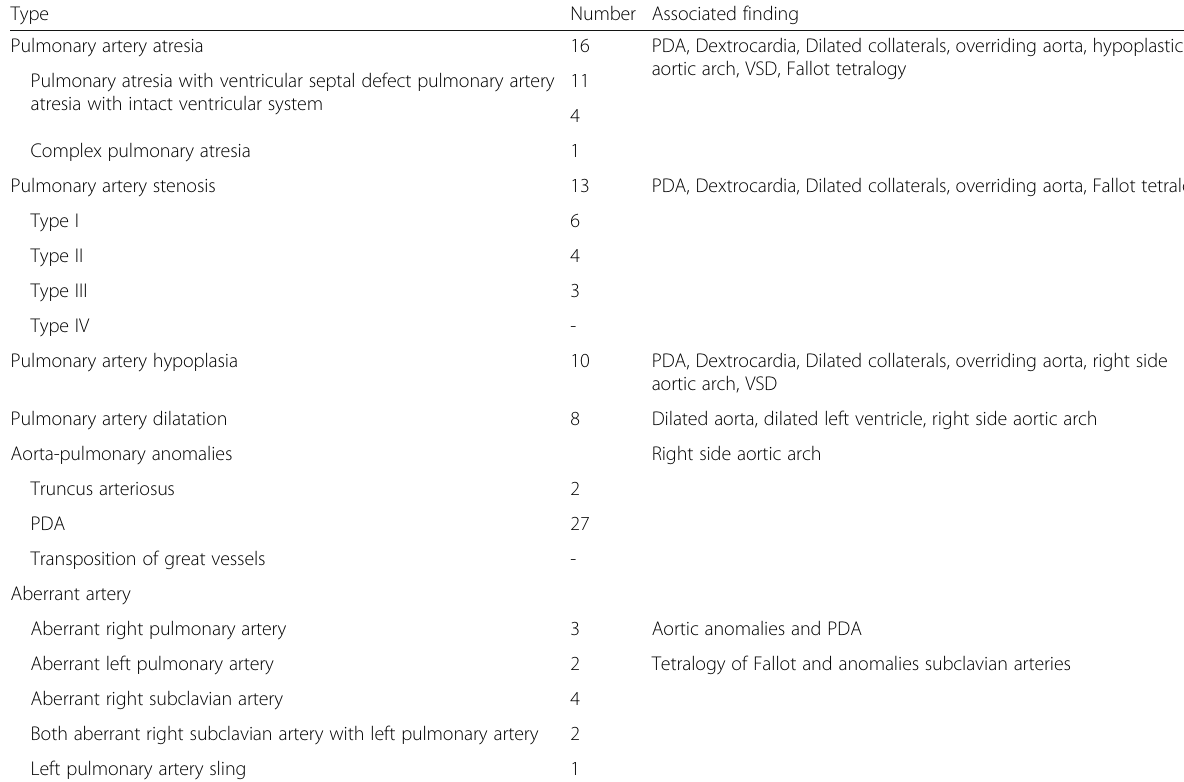
Table 1 Associated finding with the pulmonary artery anomalies Type Number Associated